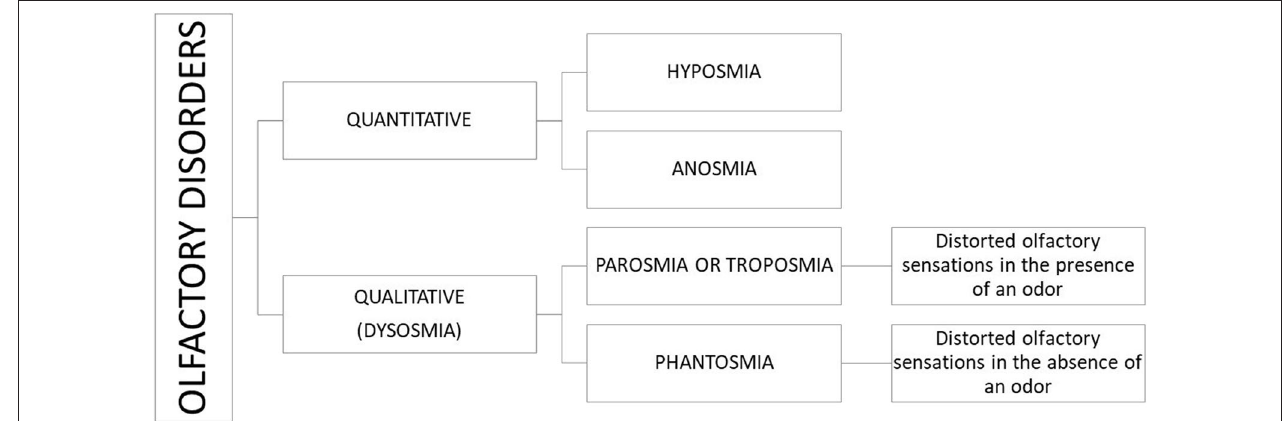
FIGURE 1 | Classification of olfaction